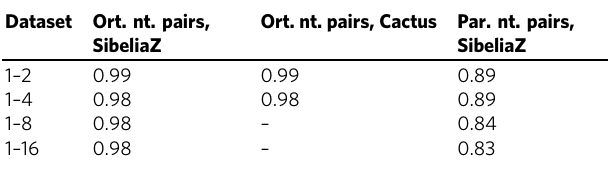
Table 3 Recall of the orthologous and paralogous basepairs by the multiple whole-genome alignments computed by SibeliaZ and Cactus from the mice datasets, using Ensembl gene annotation as the ground truth. Recall of paralogs by Cactus is not included (see